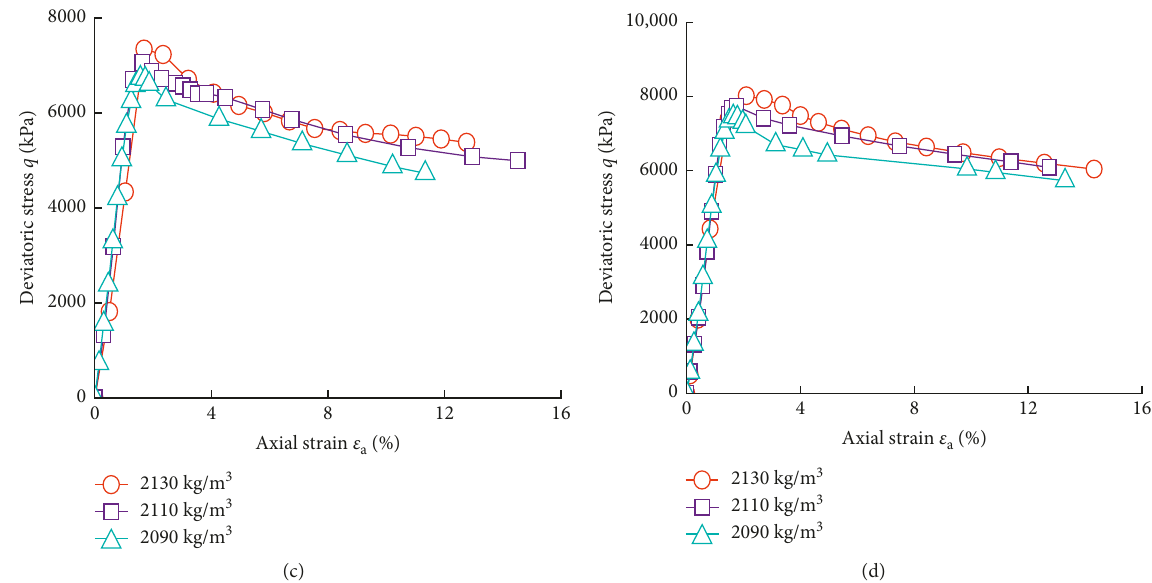
Figure 6: Stress-strain curve of CSG material considering the effect of aggregate content under various confining pressures: (a) 300kPa; (b) 600kPa; (c) 900kPa; (d) 1200kPa.